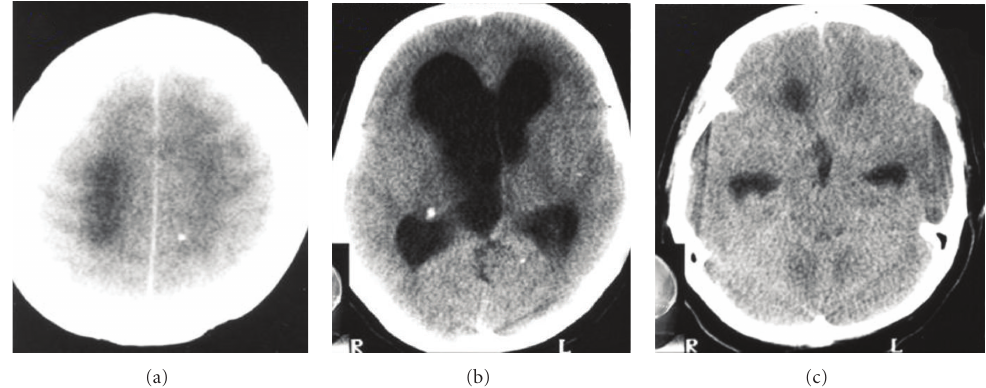
Figure 1: Noncontrast computed tomography (CT) scans (2003). (a) Parasagittal convexity. (b) Thalami. (c) Cerebral peduncles. There is ventricular enlargement with intracranial hypertension, and calcified nodules are scattered in the brain parenchima.